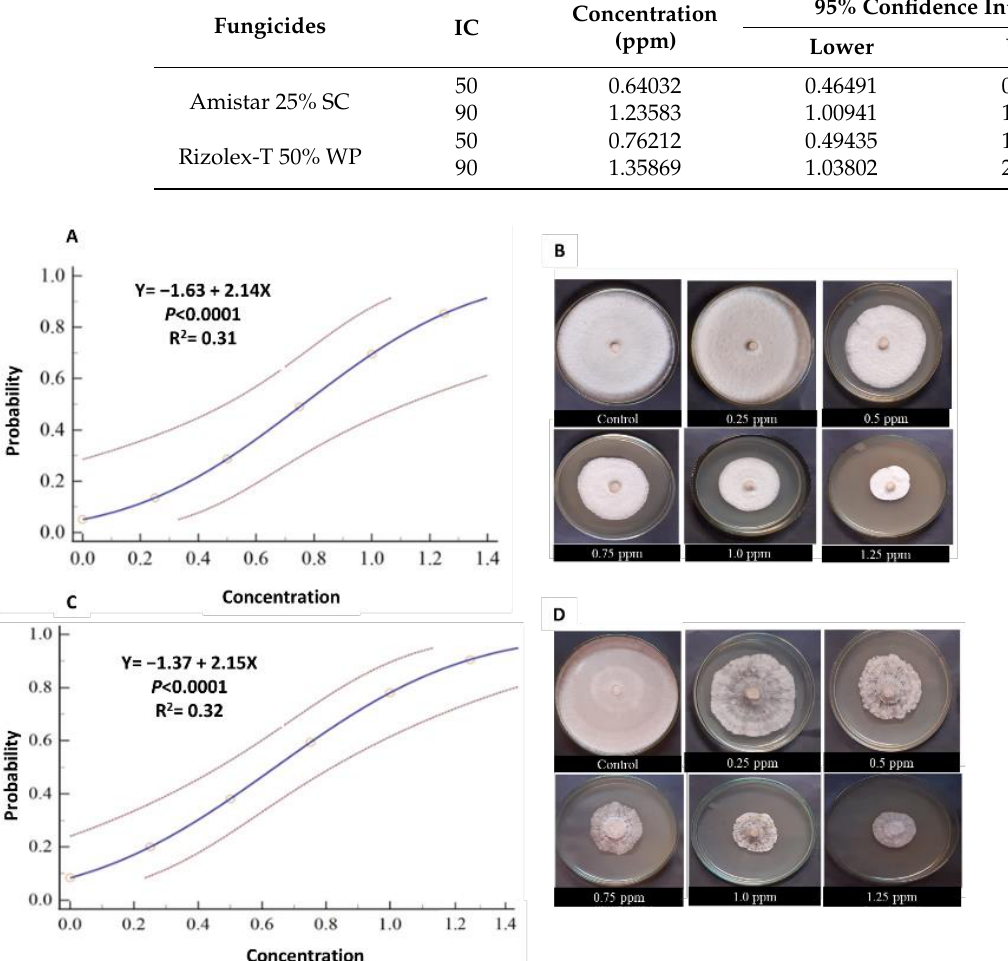
Figure 2. Probit regression analysis of the inhibition effects of Rizolex-T 50% WP ( A , B ) and Amistar 25% SC ( C , D ) against R. solani . Each treatment is represented by five replicates ( n = 5). The dose–response regression lines are presented as a blue line. R 2 and p -value based on the F test ( p < 0.05) are shown within the graphs. Table 1. The half-maximal inhibitory concentration (IC) values (ppm) for Amistar 25% SC and Ri- zolex-T 50% WP.